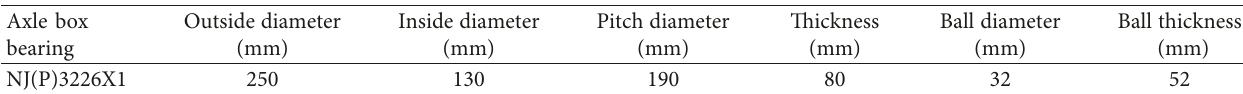
Table 3 into the PSO-LSSVM model for training. The